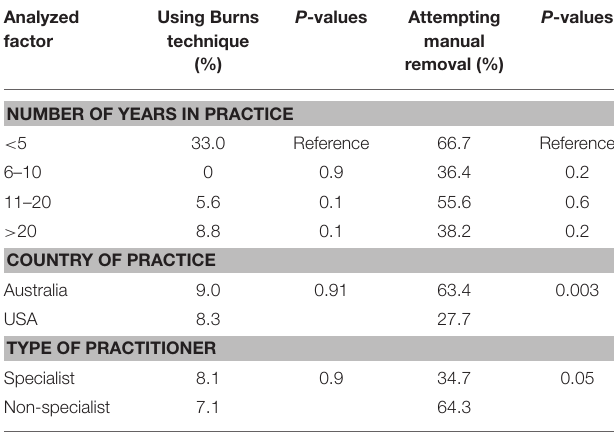
TABLE 2 | Percentage of practitioners using Burns technique for uterine flushes and attempting manual removal of fetal membranes based on univariate analysis of the factors number of years in practice, country of practice, and type of